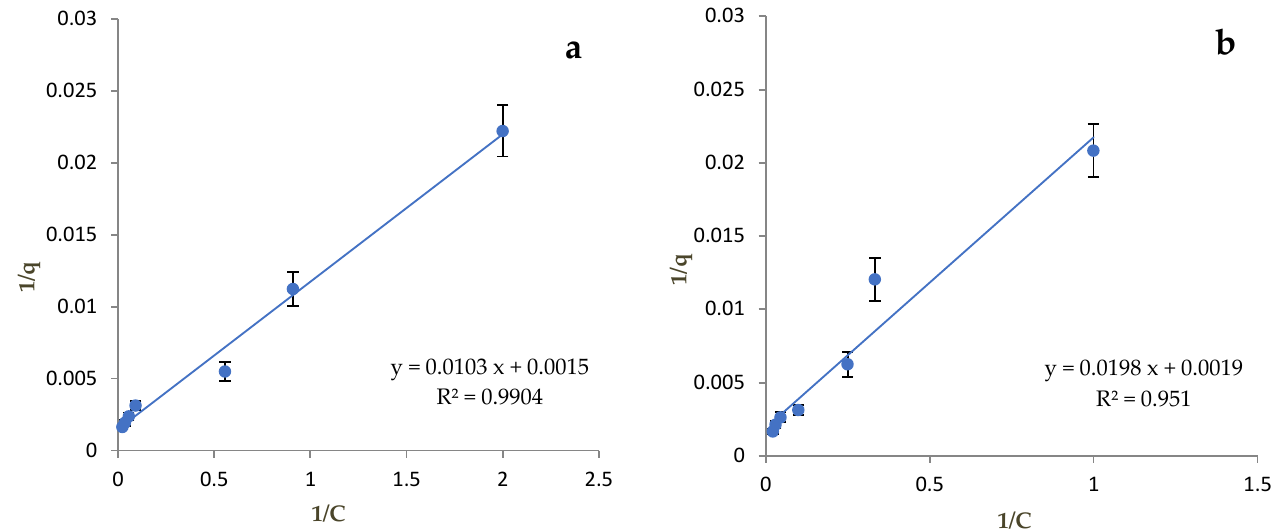
Figure 5. The Langmuir isotherm adsorption of Zn in the presence of Pb in the alkaline soil sample ( a ) and in the acidic soil sample ( b ).